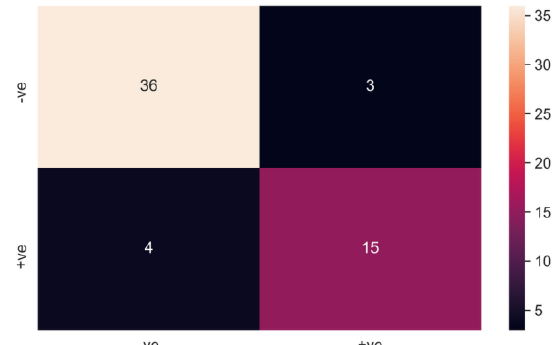
Figure 7. Confusion Matrix of AdaBoost Classifier